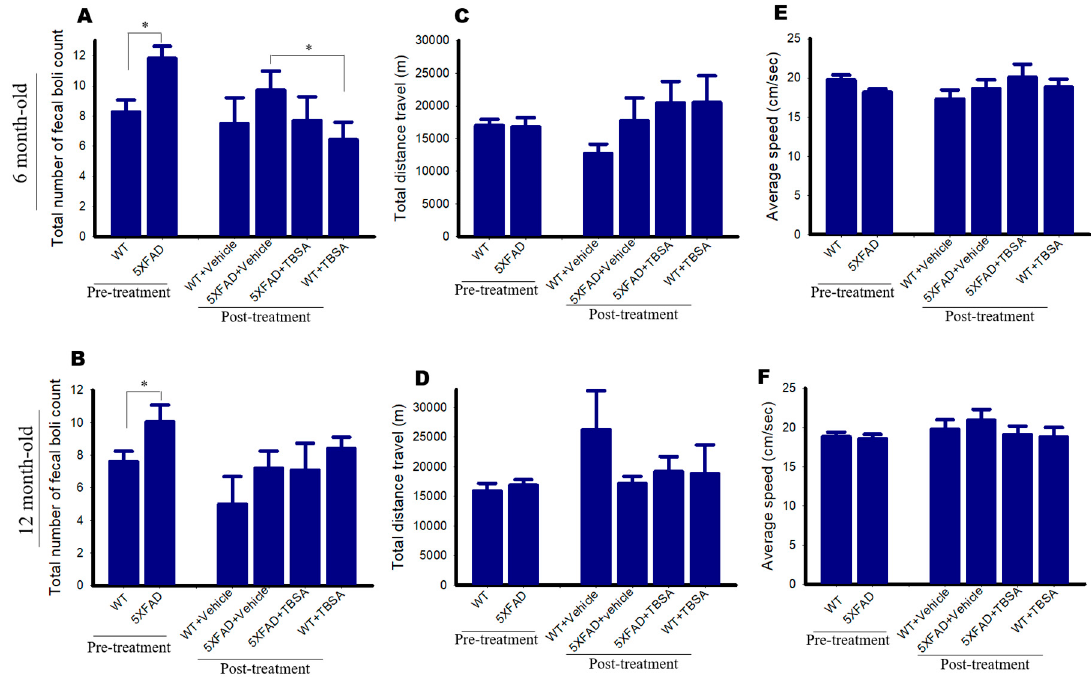
Figure 7. Effects of trans-beta-styryl-boronic acid (TBSA) compound on anxiety and activity levels in 5xFAD mice. The open-field test was used to access overall activity and anxiety in mice, both pre- and post- treatment. ( A , B ): The total number of fecal boli excreted during the open-field test, which is a commonly used measure of anxiety, in both the 6-month-old ( A ) and 12-month-old ( B ) group of mice increased in 5xFAD mice prior to treatment, with TBSA-treated 5xFAD excreting fewer boli than untreated 5xFAD mice during posttreatment testing. ( C – F ): No significant between-group differences were observed in total distance travel ( C , D ) and average speed ( E , F ) for both pre- and post- treated mice in either age group. Values are expressed as means ± SEM. * p < 0.05 in comparison to WT + Vehicle.